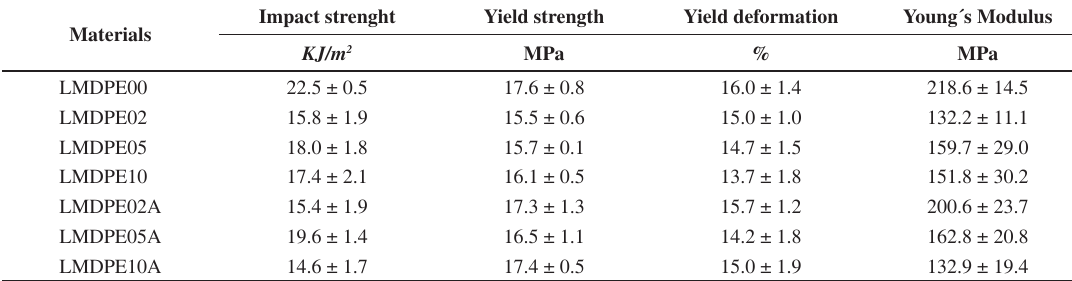
Table 7. Mechanical properties of rotational molded samples.